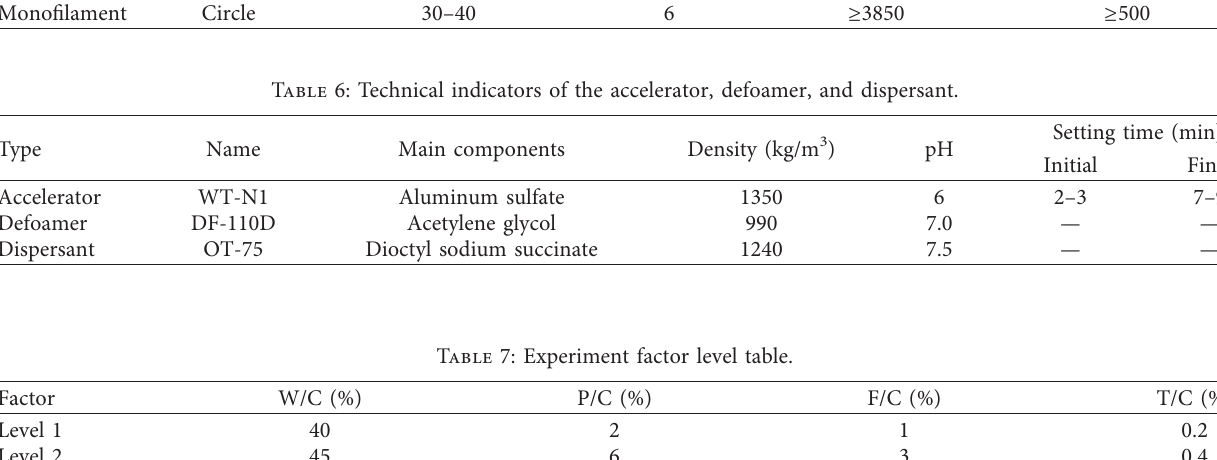
Table 5: Physical properties of polypropylene fibers.